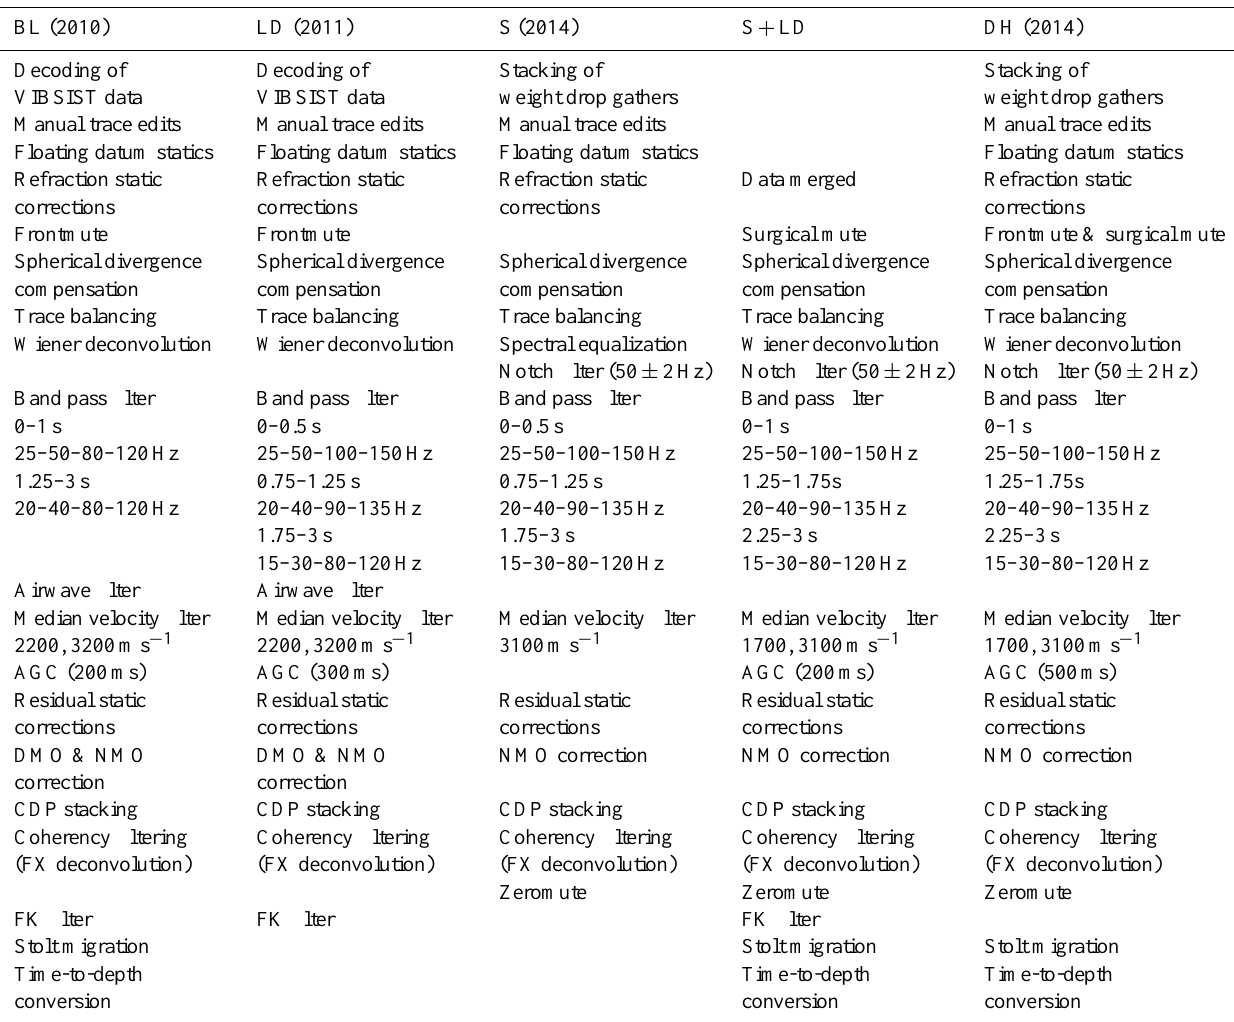
Table 2. Processing steps and parameters for the Byxtjärn-Liten profile (BL, 2010), Liten-Dammån profile (LD, 2011), Sällsjö profile (S, 2014), and Dammån-Hallen profile (DH, 2014). BL, S + LD ,and DH were merged prior to migration to form the composite COSC seismic profile,